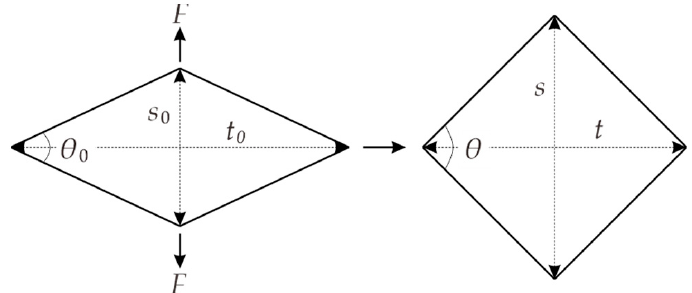
Figure 7. Deformation mode of the